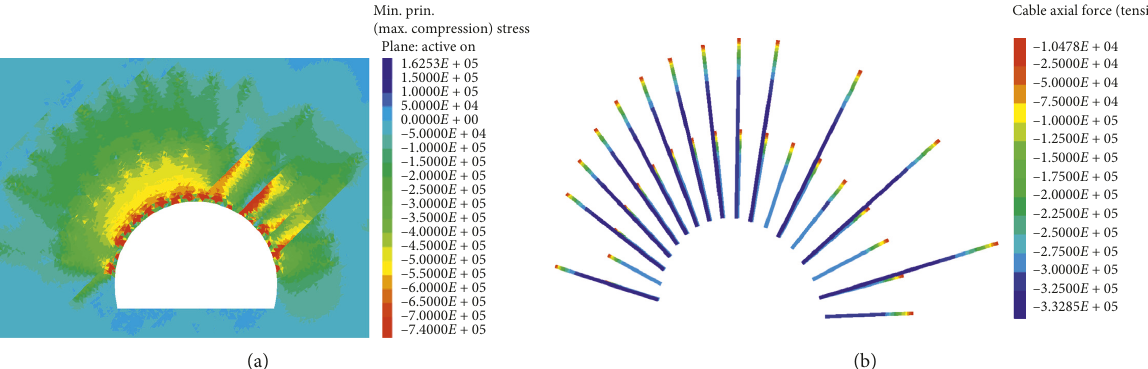
Figure 19: Long and short anchor cables under preloading 350kN. (a) Diffusion effect of anchor cable prestress. (b) Stress of the anchor